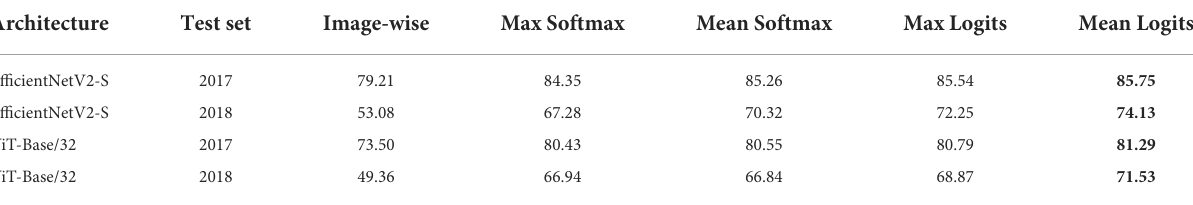
TABLE 2 Classification accuracy on the PlantCLEF 2017 and the ExpertLifeCLEF 2018 datasets for different image prediction combination strategies. Architecture